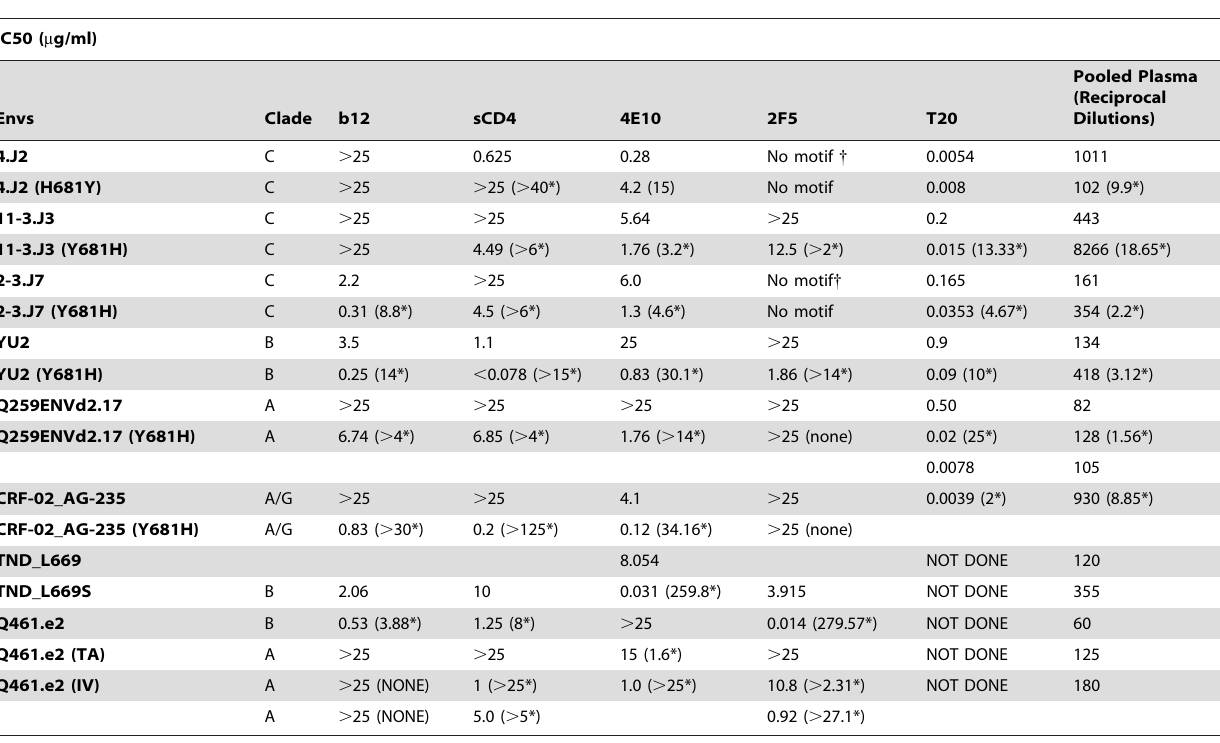
*Represents fold-increase in sensitivity of Env-pseudotyped viruses expressing H681 compared to those expressing Y681. { The minimum DKW motif necessary for 2F5 recognition is absent. The overall differences in sensitivity of Envs expressing H681 with that of Y681 to sCD4 and 4E10 MAb were significant (P=0.0002 and P=0.008). TND-L669 and TND_L669S [44] as well as Q461.e2, Q461.e2 (TA) and Q461.e2 (IV) [43] that were earlier reported to enhance sensitivity of HIV-1 to neutralizing antibodies were tested in parallel. Fold differences in neutralization sensitivities are given in parentheses.